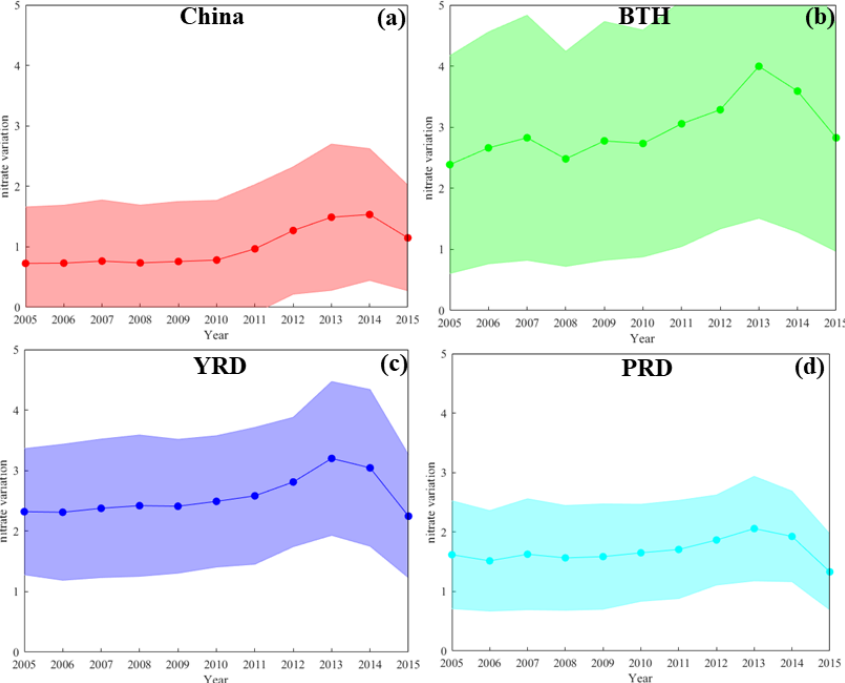
− concentrations in major regions across China during 2005–2015. The solid lines denote the mean NO − 3 3